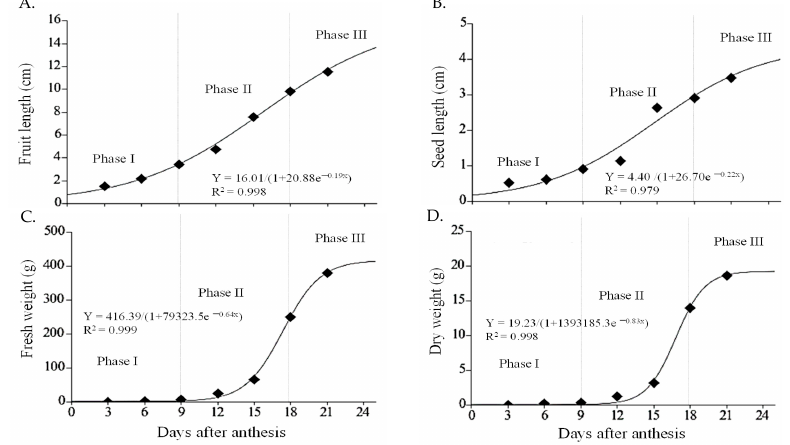
Figure 2. Fruit and seed development of chayote Sechium edule var. virens levis at 3, 6, 9, 12, 15, 18, and 21 daa = days after anthesis; cd = cotyledon development ( n = 10 ± standard deviation).